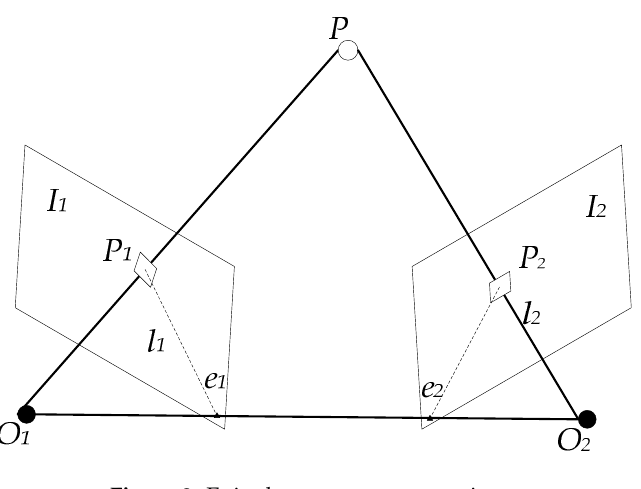
Figure 2. Epipolar geometry constraints.